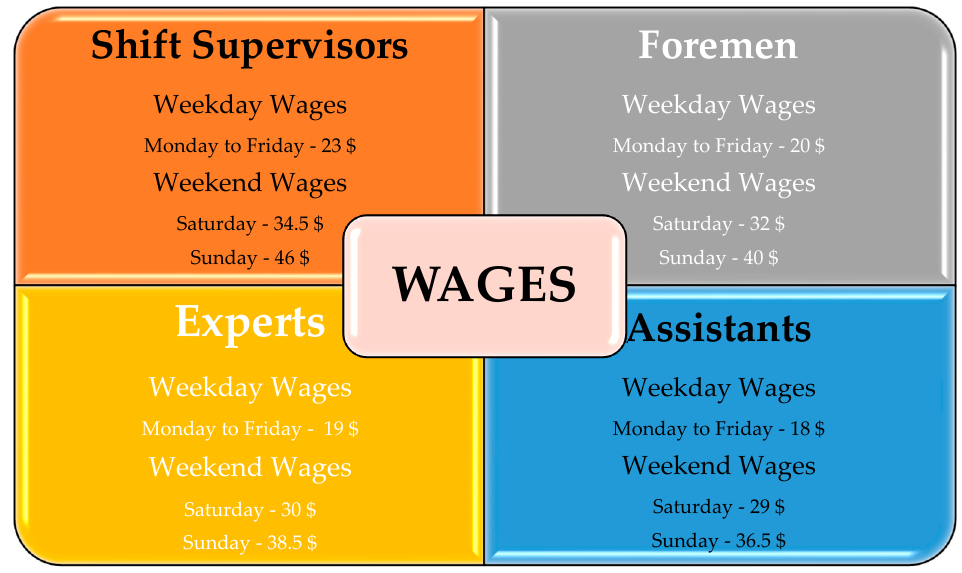
Figure 2. The wage Figure 2. The wage details.